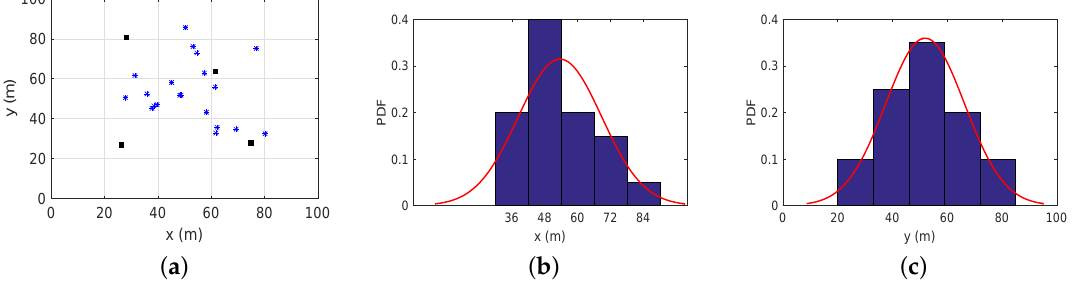
Figure 8. Estimation for 20 agent nodes’ distribution: ( a ) actual positions; ( b ) the estimation for the x -axis distribution probability; ( c ) the estimation for the y -axis distribution probability. The red curves are the estimated distribution probabilities, and the histograms are the actual distribution probabilities.